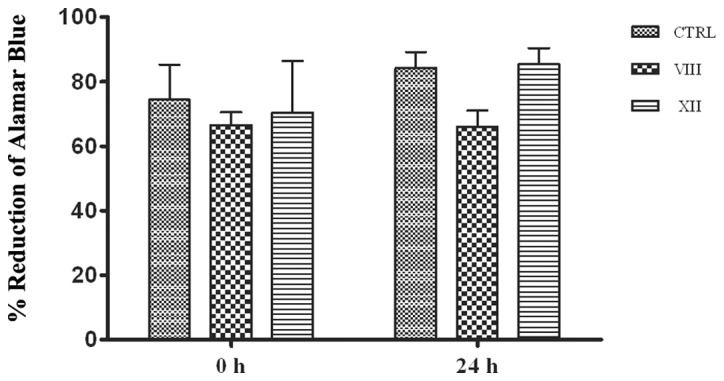
Cytotoxicity and proliferation of MSC upon AKT inhibition. % of Alamar Blue reduction at time zero (0 h) and 24 h after drug-treatment.